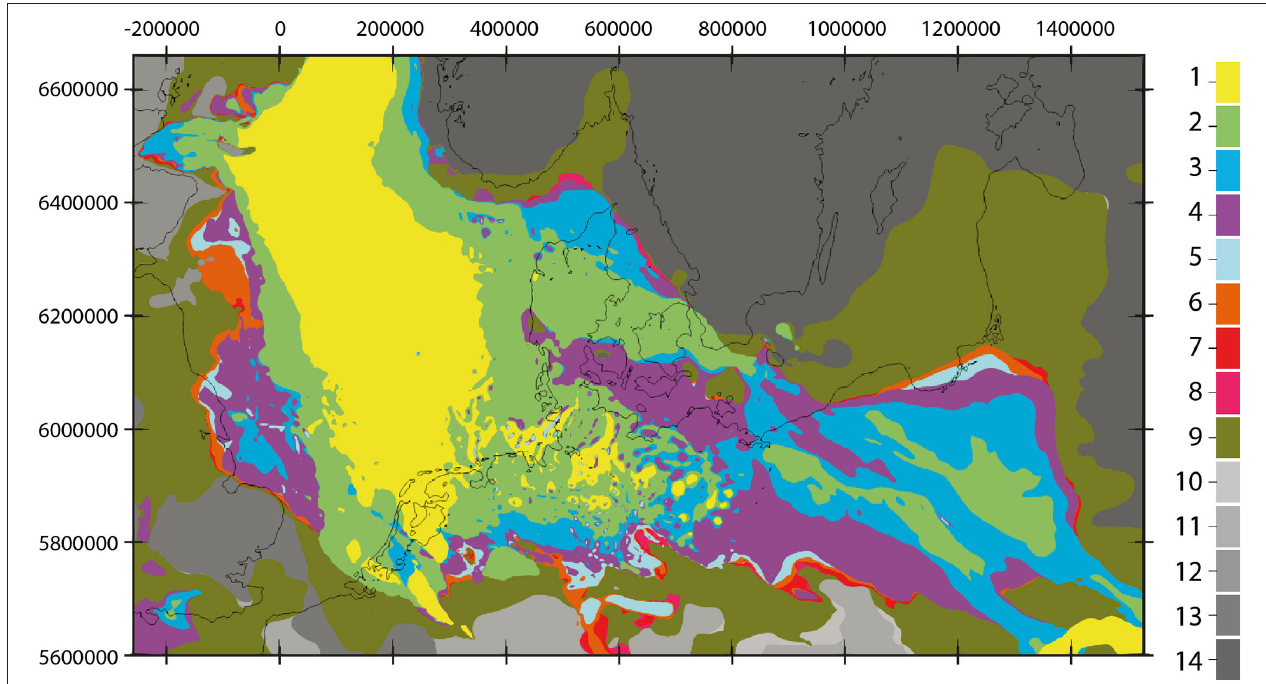
FIGURE 3 | Distribution of geological units extracted at − 1,000m b.s.; different colors rep- resent different geological units: 1 = Tertiary, 2 = Cretaceous, 3 = Jurassic, 4 = Triassic, 5 = Permian Zechstein Salt, 6 = Permian Carbonates, 7 = Rotliegend Sediments, 8 = Permocarboniferous Volcanics, 9 = Pre-Permian Sediments, 10 = Bohemian Granite, 11 = Variscan Crust, 12 = Laurentia Crust, 13 = Avalonia Crust, 14 = Baltica Crust. Coordinates are in UTM Zone